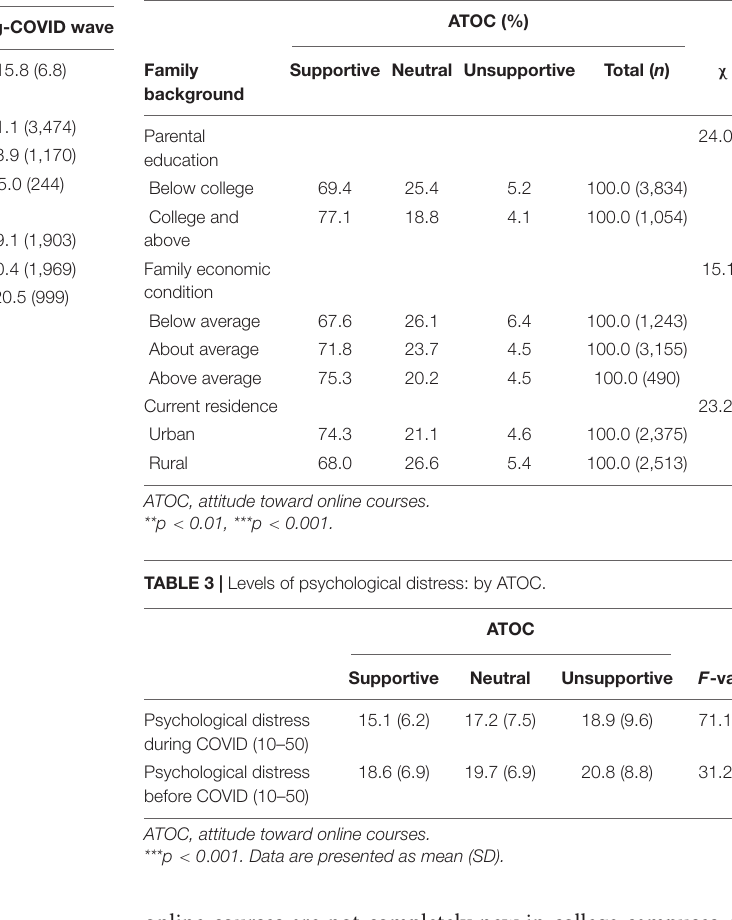
TABLE 1 | Descriptive statistics ( N = 4,888). TABLE 2 | Distribution of ATOC: by family backgrounds.